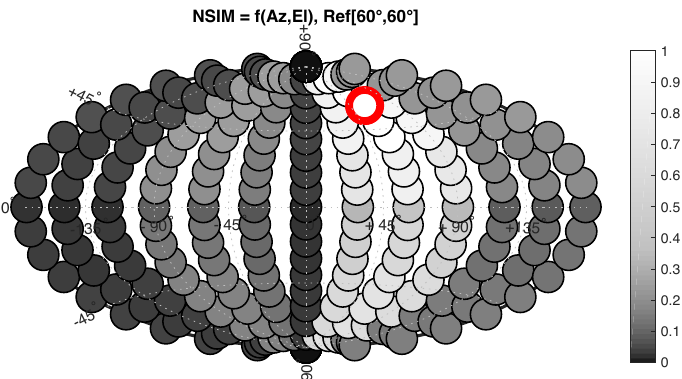
Figure 13. Localization accuracy scores distributed on a sphere. The reference audio source was localized at azimuth = 60 ◦ , elevation = 60 ◦ (the red circle represents the reference audio source). Reproduced from